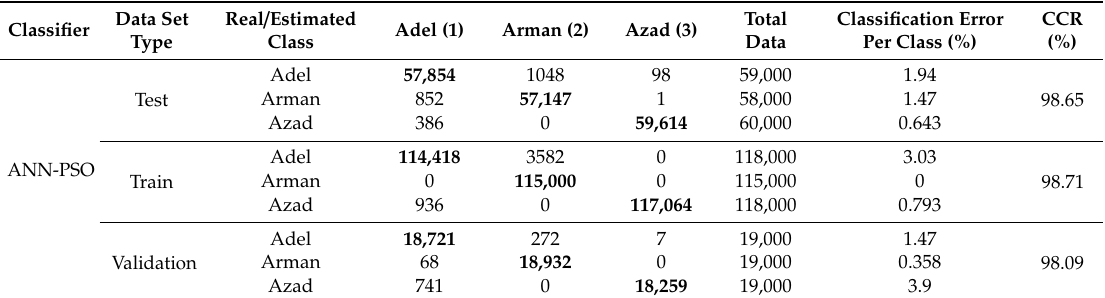
Table 5. Confusion matrix including correct classification rate (CCR) for the ANN-PSO classifier: Adel, Arman and Azad chickpea ( Cicer arietinum L.) varieties (1000 random iterations, test, train and validation sets).